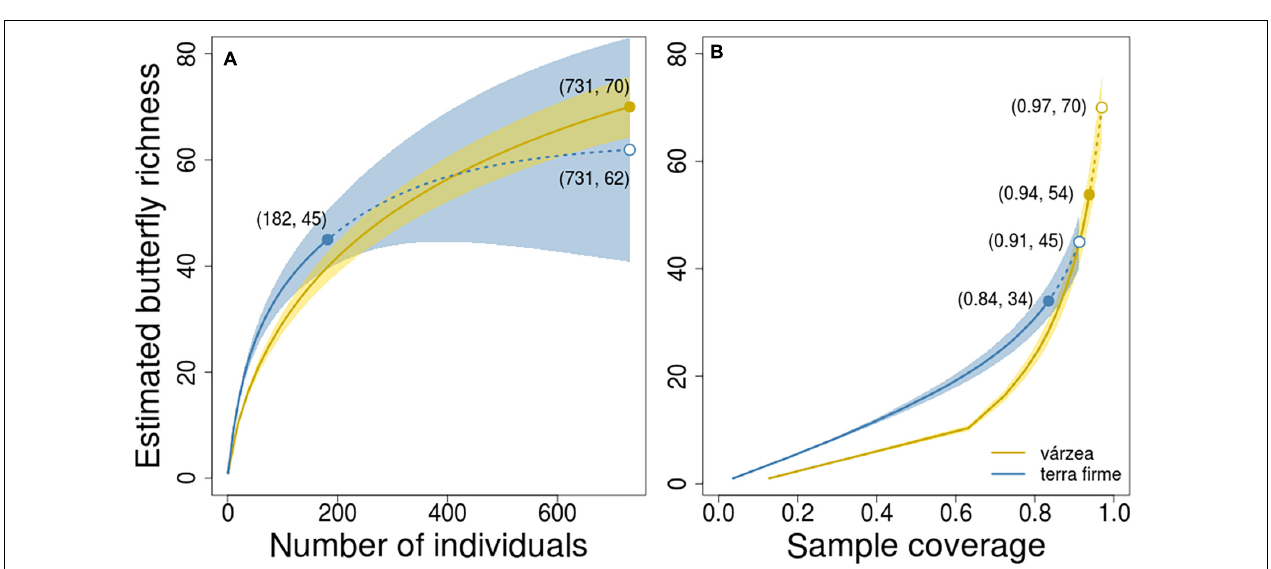
FIGURE 3 | Butterfly richness estimated by rarefaction (solid curves) and extrapolation (dashed curves) based on sample size (A) and completeness, (B) with corresponding 95% confidence intervals (shaded areas). Solid circles indicate the observed species richness and open circles indicate the extrapolated richness in terra firme assemblages based on number of individuals (A) or sample coverage. (B) Numbers within parentheses indicate the coordinates in both graphs. Although estimated richness in várzea seems to be higher than terra firme at its maximum sample size (731 individuals in “ A ”) or completeness (0.97 of coverage in “ B ”), the confidence intervals overlap and indicate the there is no statistically significant difference in richness between the two forest